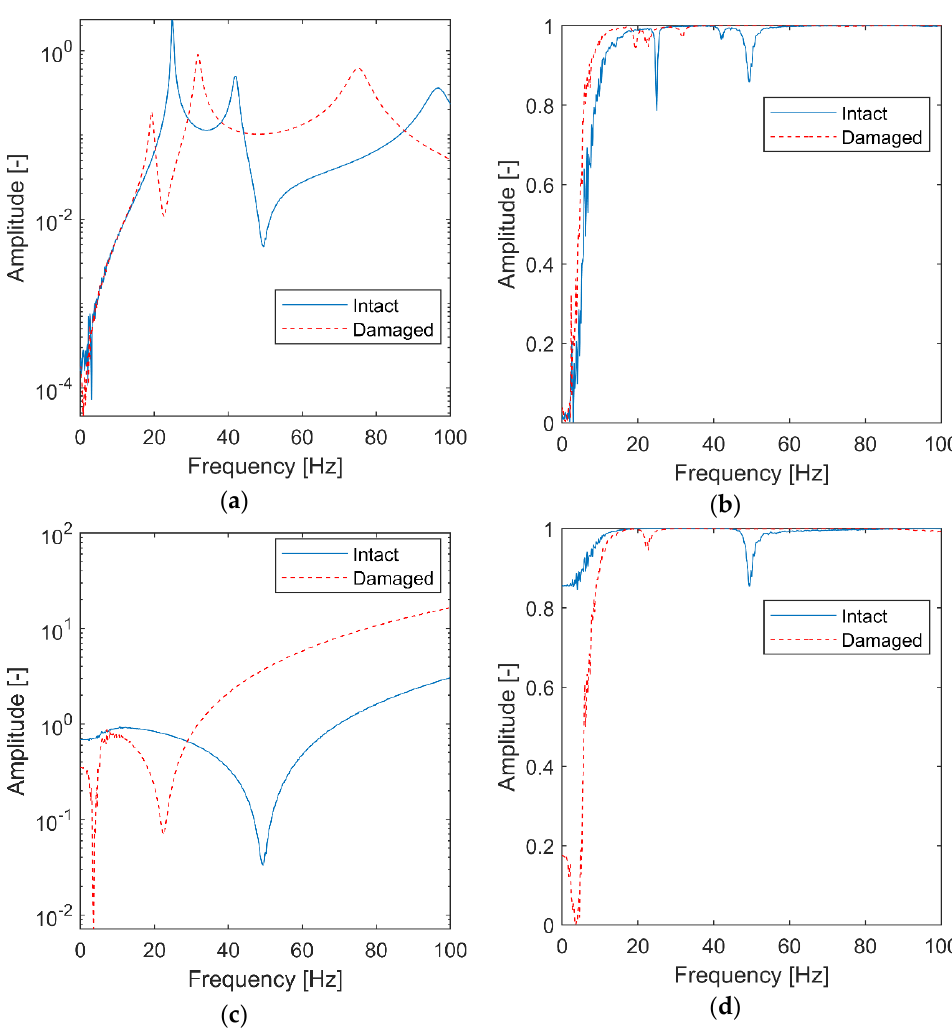
Figure 2. Classical analysis for the simulated LTI system: ( a ) FRF in a logarithmic scale; ( b ) FRF coherence; ( c ) transmissibility; ( d ) transmissibility coherence. coherence; ( c ) transmissibility; ( d ) transmissibility